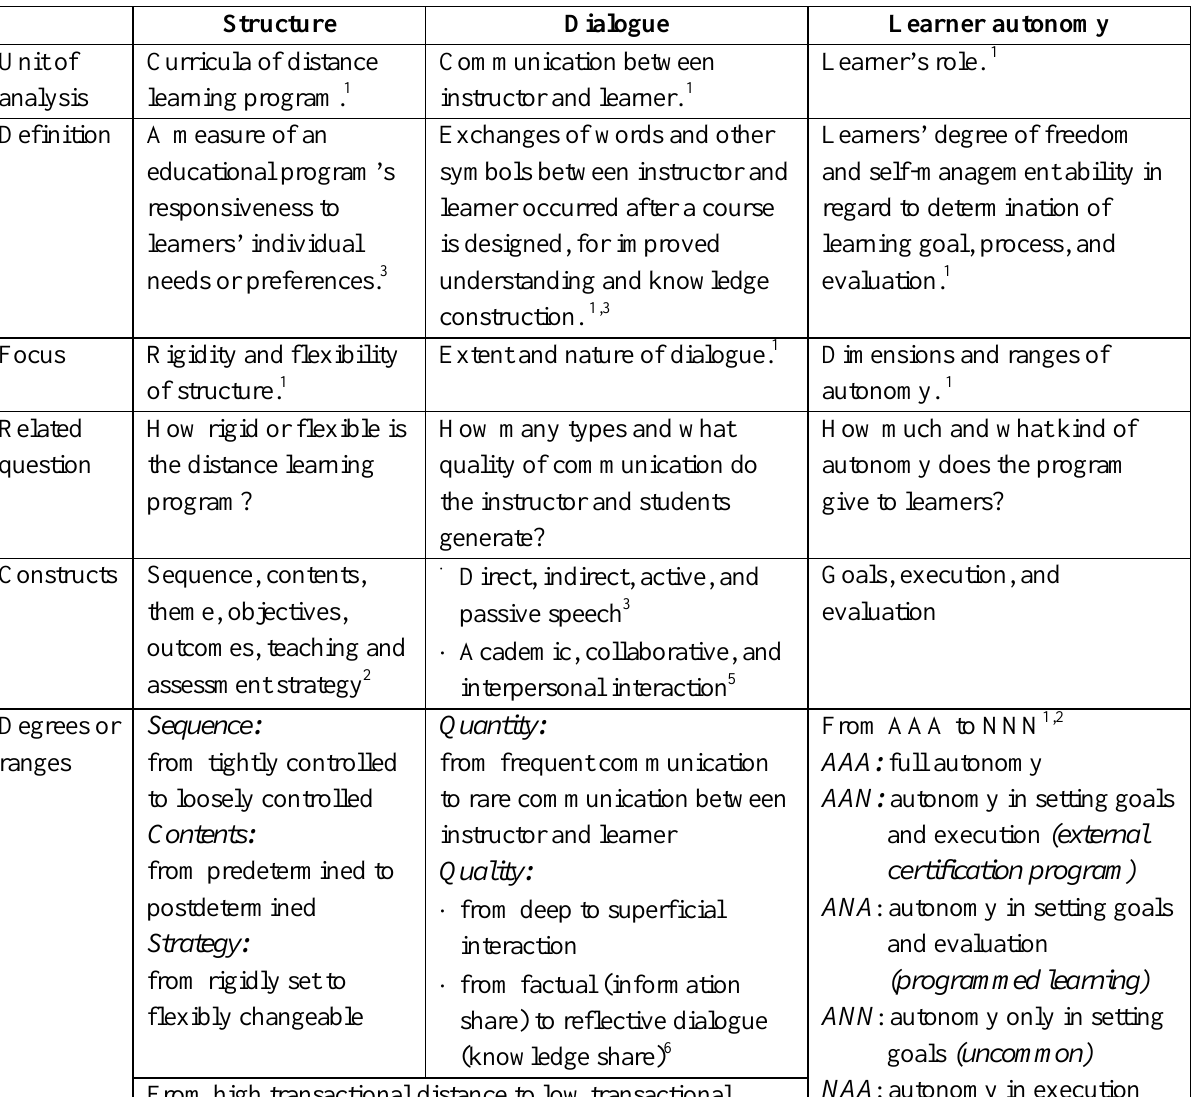
The Three Elements of Original Transactional Distance